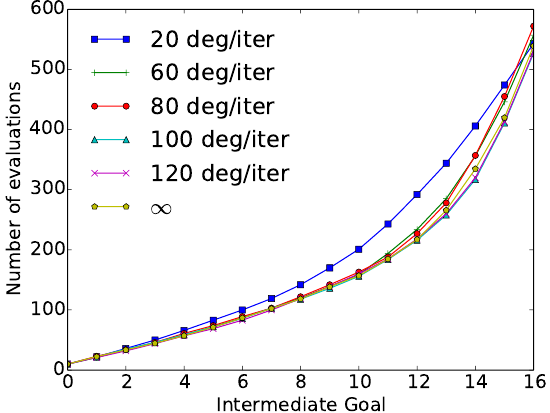
Figure 10. “Paint” velocity constraint experiment results: Cumulative number of evaluations at each intermediate goal for different Velocities (20, 60, 80, 100, 120 degree/iteration and ∞